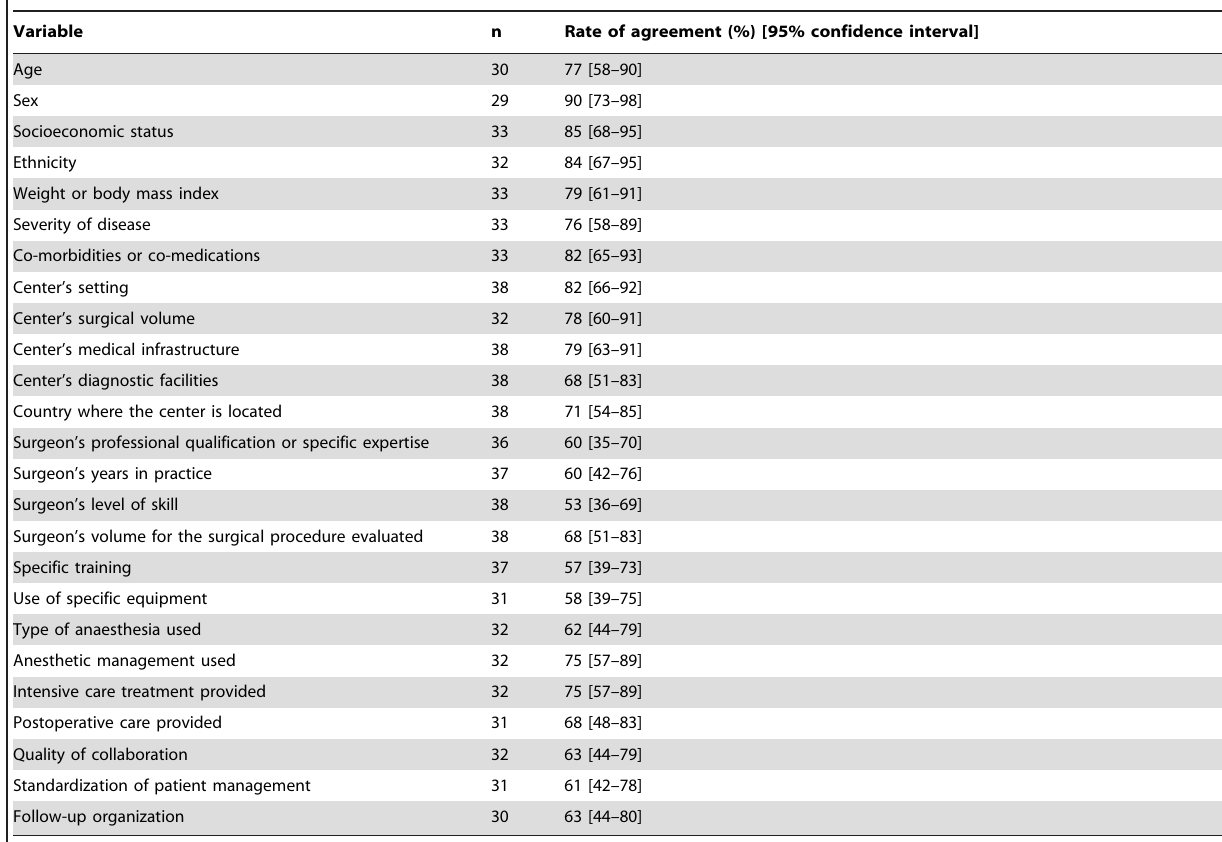
Table 3. The reproducibility of evaluating applicability by surgeon authors of the same